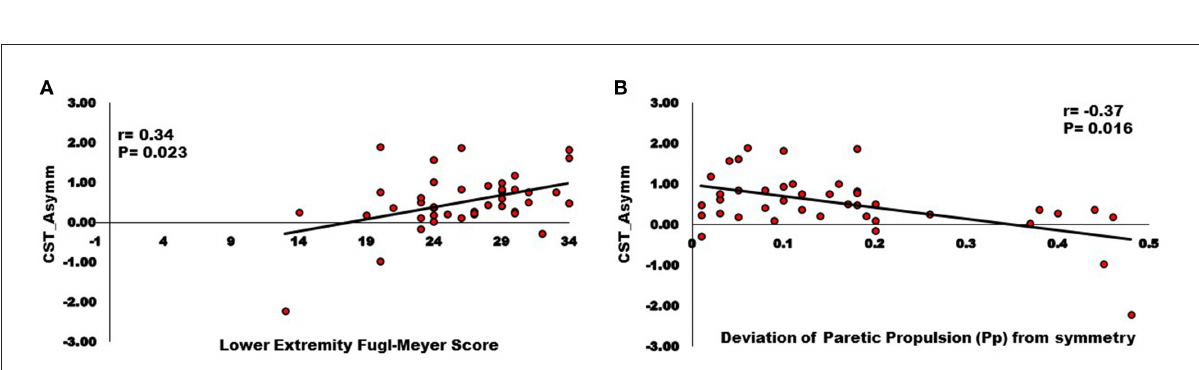
FIGURE3 Relationships between Inter-hemispheric asymmetry of CST streamlines and (A) Lower extremity Fugl-Meyer score; (B) Deviation of paretic propulsion (Pp) from symmetry. The Asymm Stroke for CST (i.e., fewer CST streamlines on the lesioned hemisphere) were positively correlated with Lower extremity Fugl-Meyer score, and negatively correlated with deviation from symmetric Pp ( p < 0.05).